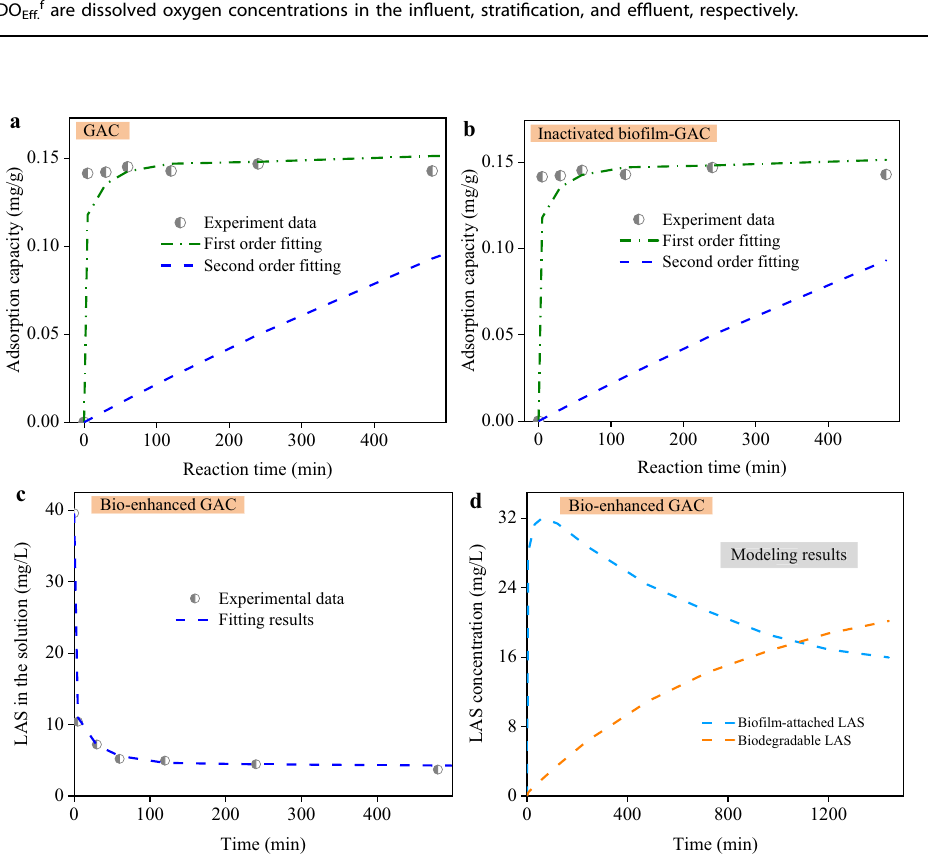
Fig. 3 LAS removal kinetics. Batch experiments for the removal kinetics of LAS in a fresh GAC, b inactivated bio fi lm-GAC, c bio-enhanced GAC, and d the modeling results in the bio-enhanced GAC. The pseudo- fi rst order and the pseudo-second-order models were used for the LAS adsorption kinetics fi tting in the fresh GAC and inactivated bio fi lm-GAC; a two-step removal model including bio fi lm adsorption and biodegradation was used for the simulation of LAS removal in the bio-enhanced